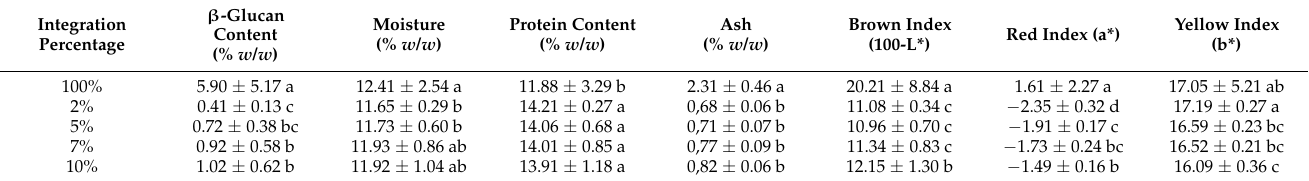
Table 3. Physicochemical features to the different percentages of integration of two flours: two-factor ANOVA (analysis of variance) (data are means ± standard deviations).